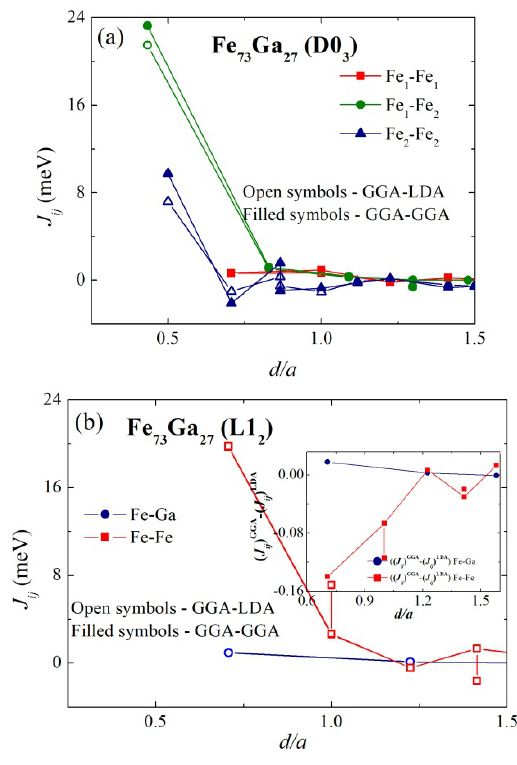
Fig. 3. The calculated exchange interaction parameters J ij as a function of distance ( d/a ) between atoms i and j for the crystal structures (a) D0 3 and (b) L1 2 of Fe 73 Ga 27 alloy. The inset shows the difference ∆ J ij = ( J ij ) GGA -( J ij ) LDA between values of J ij obtained with GGA and LDA approximations,